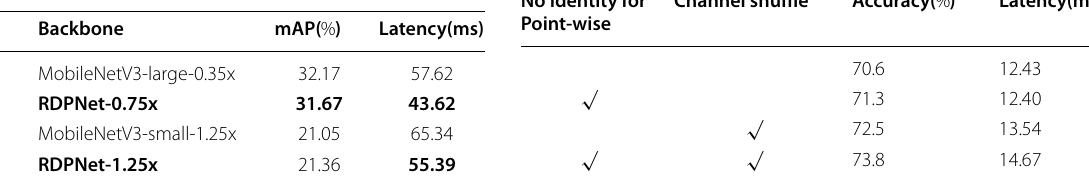
Table 6 On the PASCAL2007 dataset, RDPNet’s performance as the backbone is contrasted with that of other models